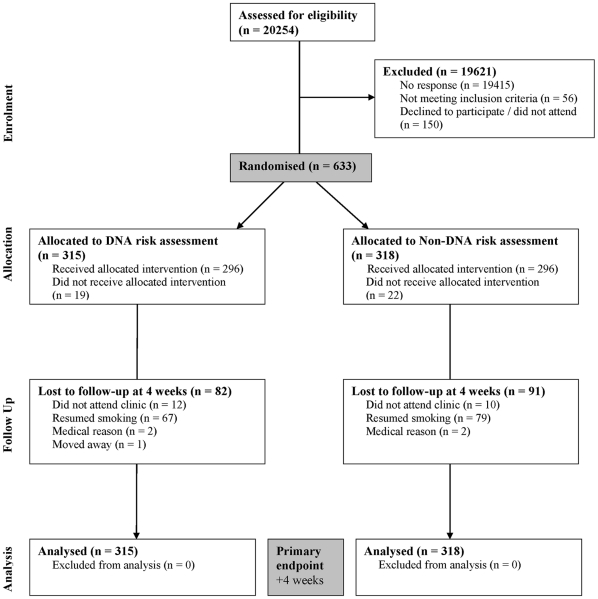
CONSORT flow diagram.